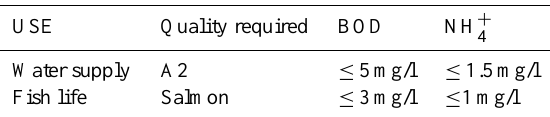
Table 4. Case study water quality objectives under current Spanish